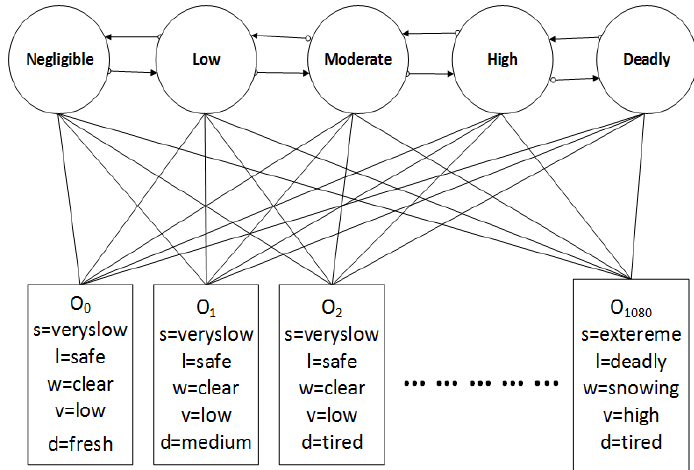
Figure 3. Graphical representation of HMM after listing all the observations combination.